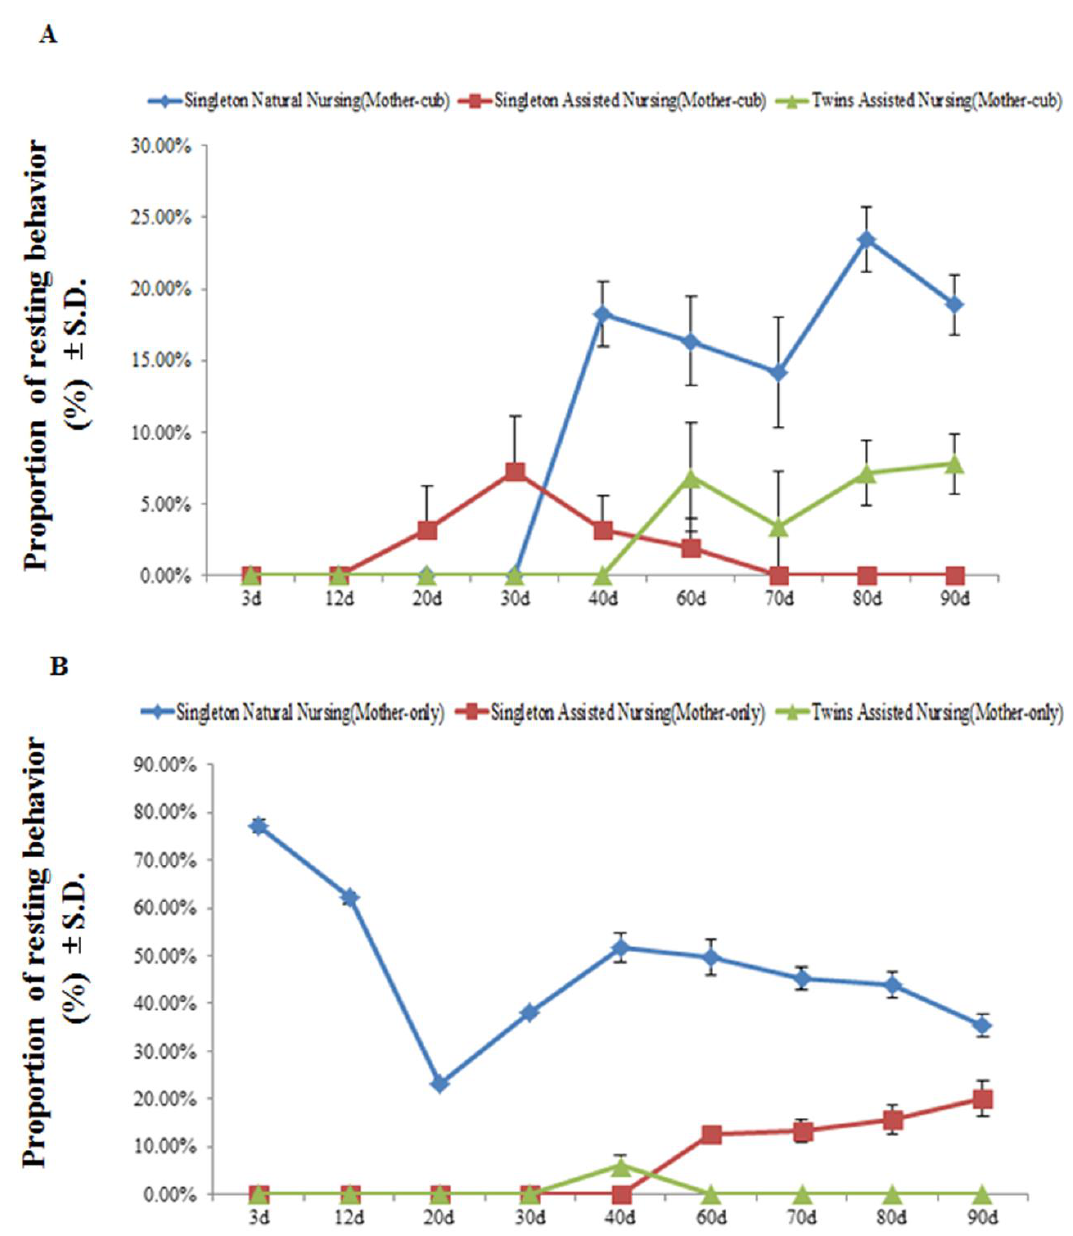
Figure 4. The percentage of time the mother engaged in resting behavior during the mother–cub (panel A ) period and mother-only period (panel B ). Data were presented as the mean ± S.D. (standard deviation). n = 3 per group.